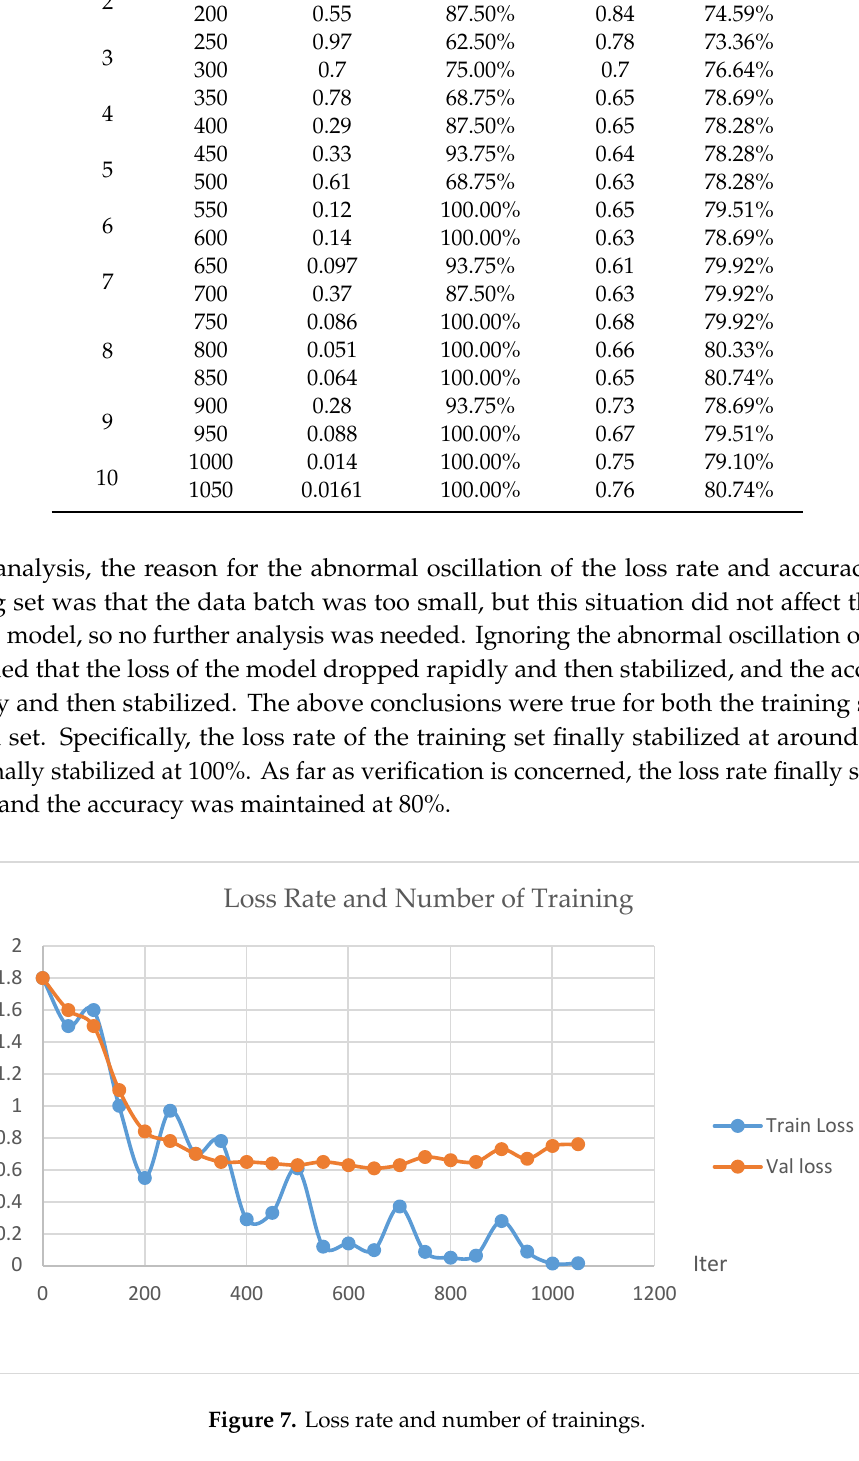
Figure 8. Accuracy and number of trainings. 3.3.2. Description of Test Results As shown in Table 3, the test results consisted mainly of two parts. Table 3 gives the various indicator values of the classification effect of each category, as well as the overall classification effect, which is convenient for the overall analysis model. Table 4 shows the classification confusion matrix. Each type can be analyzed in more depth through the confusion matrix. As shown in Table 3, there were two indicators—that is, the loss rate and the accuracy rate— which were 0.62 and 80.29% respectively. As analyzed in the previous section, there was no substantial difference between the verification process and the training process. Therefore, the loss rate and the accuracy rate on the test set were consistent with the analysis of the verification set; the loss rate was finally maintained at 0.6 and the accuracy was maintained at 80%.